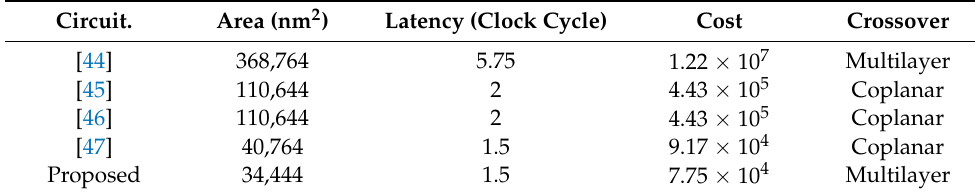
Table 5. Comparison of QCA CAMs.